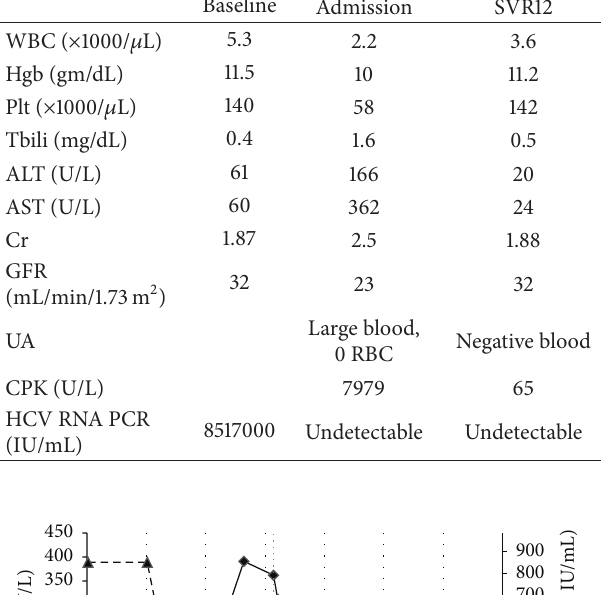
Table 1: Pertinent laboratory results.